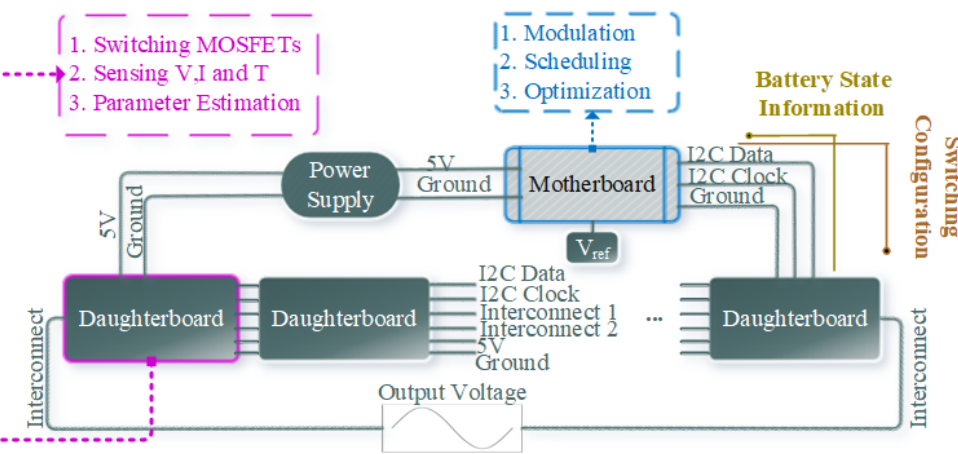
Figure 7. Design overview of the converter system with the motherboard and daughterboard functions ordered in